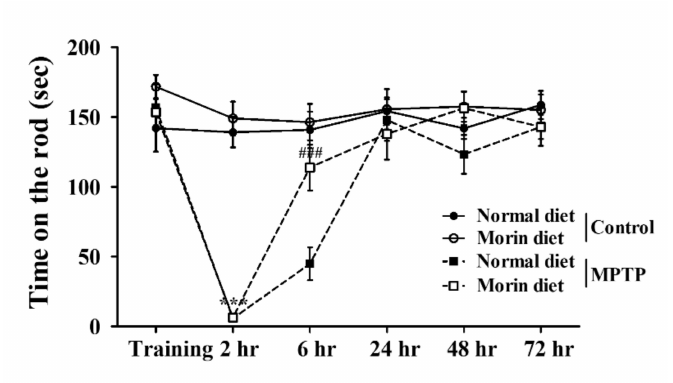
Figure 2. Morin effectively attenuated motor dysfunction in our murine PD Model. Rotarod testing was used to evaluate motor function. Mice were pre-trained for three days to remain on the rod at 15 to 30 rpm. The tests were performed at 2, 6, 24, 48 h, and 72 h after the last MPTP injection at a rod speed of 30 rpm. Data are presented as means ± SEMs. *** p < 0.001 vs. control normal diet, ### p < 0.001 vs. MPTP normal